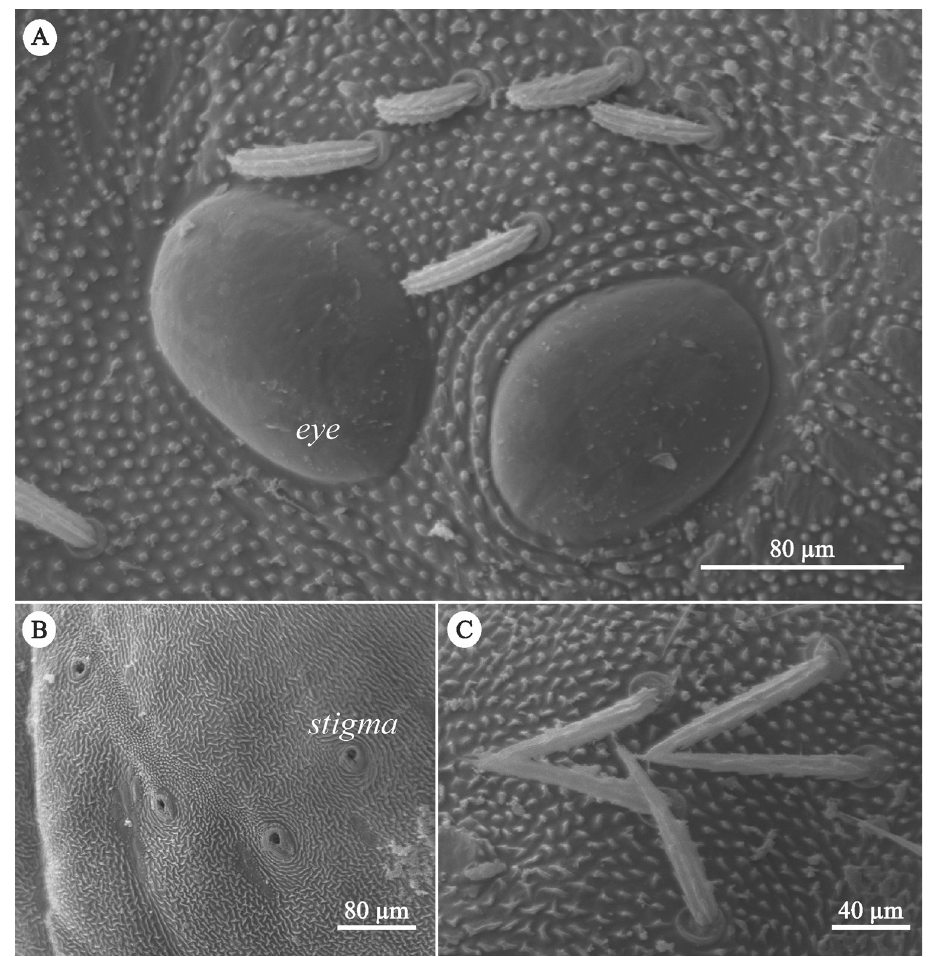
Figure 4. Neocarus spelaion sp. n. (female): A View of eyes and prodorsal setae B View of the stigmas C View of the sternitogenital setae (barbed and